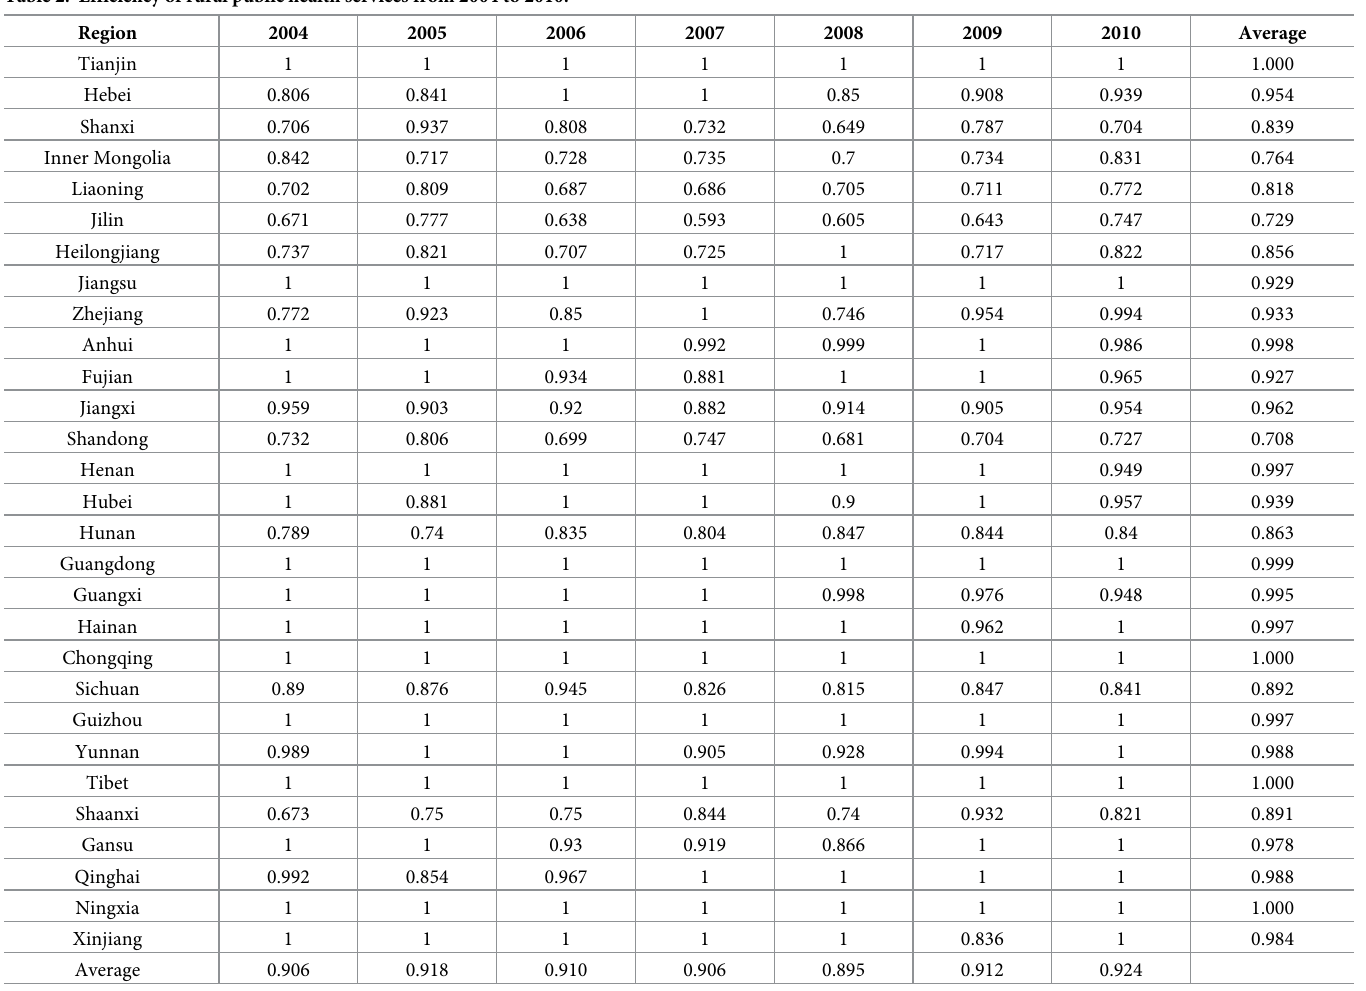
Table 2. Efficiency of rural public health services from 2004 to